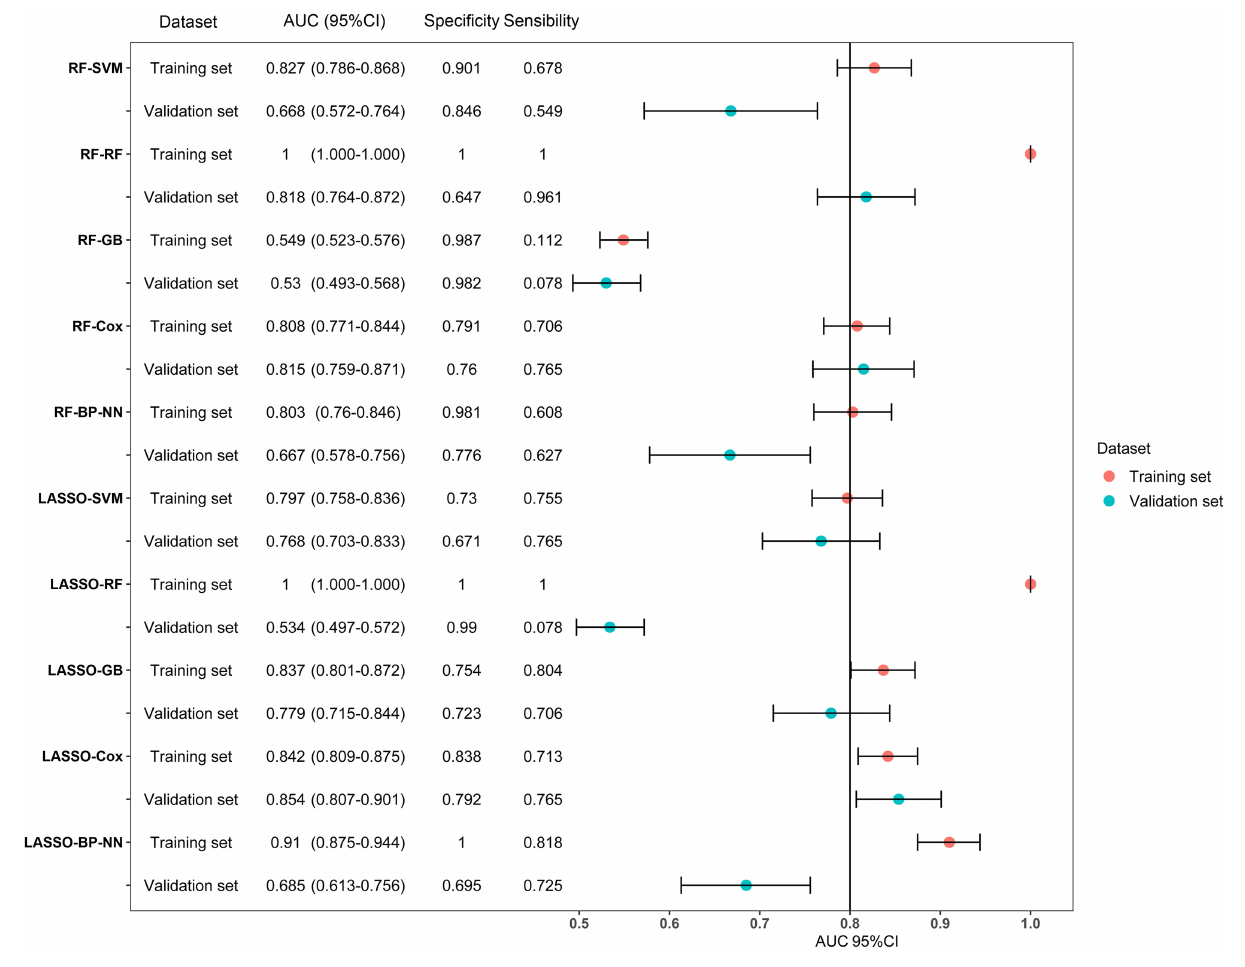
FIGURE 3 | Forest plot of area under the curves (AUC) of the training and validation datasets for the ten models. AUCs are shown with 95 percent confidence intervals for training set and validation set in each algorithm group. RF, random forest; SVM, support vector machine; GB, gradient boosting; BP-NN, backpropagation neural network; LASSO, least absolute shrinkage and selection